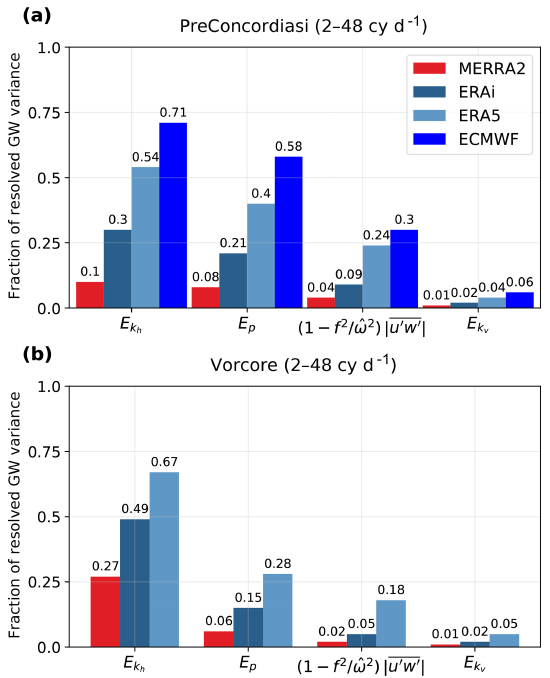
Figure 8. Bar chart of the fraction of resolved variance in the re- analysis balloon trajectories in the 2–48cyd − 1 frequency range, i.e., variance in the reanalysis trajectories normalized by the vari- ance present in balloon observations. Results are shown for the (a) 2010 tropical PreConcordiasi campaign and the (b) 2005 po- lar latitudes Vorcore campaign. The fields considered are, from left to right, horizontal kinetic energy E k , potential energy E p , h (cid:16) (cid:17) | u (cid:48) w (cid:48) | and vertical ki- zonal pseudo-momentum flux 1 − f 2 / ˆ ω 2 netic energy E k v